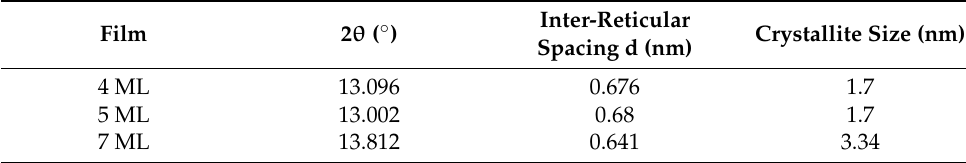
Table 1. X-ray diffraction results on MoS 2